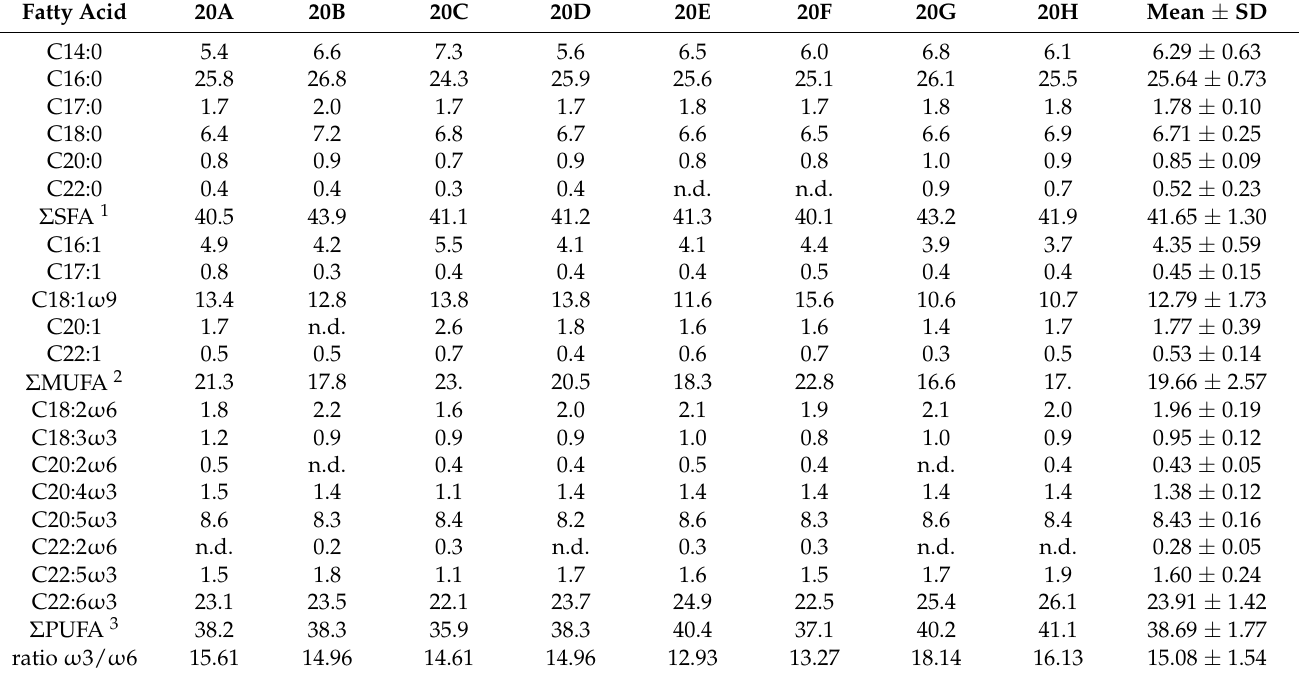
Table 1. Fatty acids composition of the stomach oil samples collected at day 20 (expressed as %). n.d. = not detected.